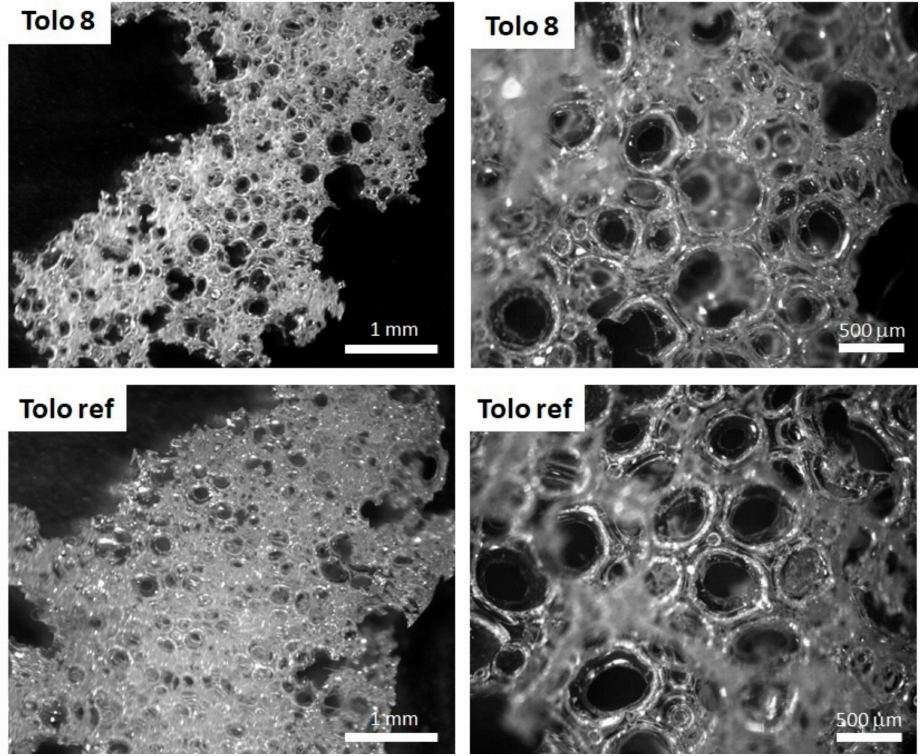
Figure 9. Optical microscope images of Tolo 8 and Tolo ref at different magnifications (10 × and 30 ×